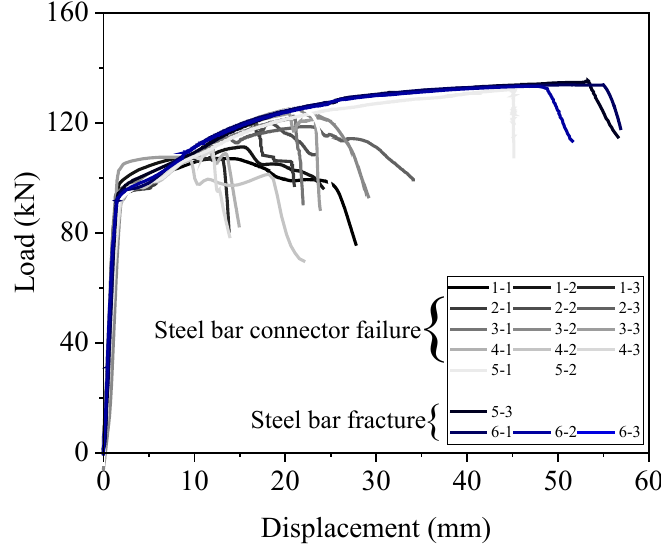
Figure 12. Load–displacement curves.